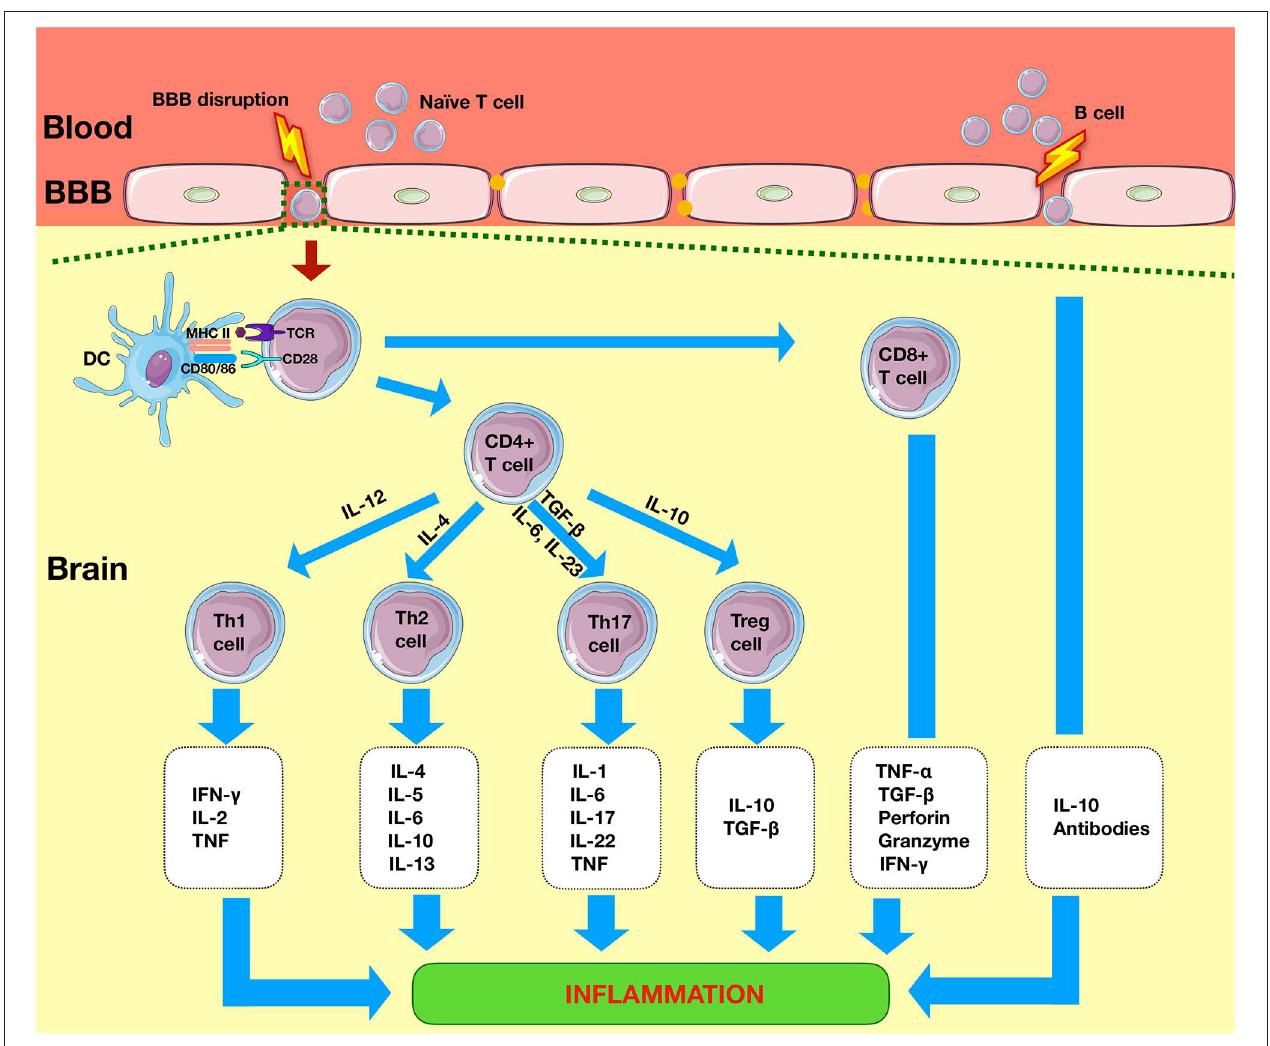
FIGURE 3 | Adaptive immunity in ischemic stroke. Within 1 day of the ischemic event, there is infiltration of system cells such as CD4 + T and CD8 + T cells. CD4 cell cells differentiate into Th1, Th2, Th17, or Tregs to produce pro-inflammatory or anti-inflammatory effects. CD8 + T cells lead to neuronal death by release of perforin and granzyme. B cells produce anti-inflammatory effects via the release of interleukins such as IL-10. TLR, Toll-like receptors; NLRP3, nod-like receptor pyrin domain-containing 3; APC, antigen-presenting cell; CD4 + , cluster of differentiation 4 + ; Th, T helper; Treg, regulatory T